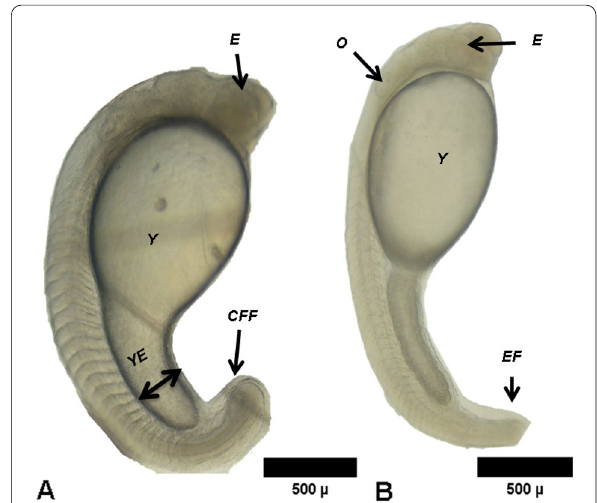
Fig. 7 Prochilodus magdalenae pharyngula period. A A completed set of somites that extend to the end of a long post‑anal tail is seen. The nervous system is hollow and expanded anteriorly; B extension and elongation of the tail were seen and the eye primordium was seen too. Abbreviations: CFF: caudal fin fold; E: eye; EF: embryonic fin; O: otic cup; Y: yolk; YE: yolk